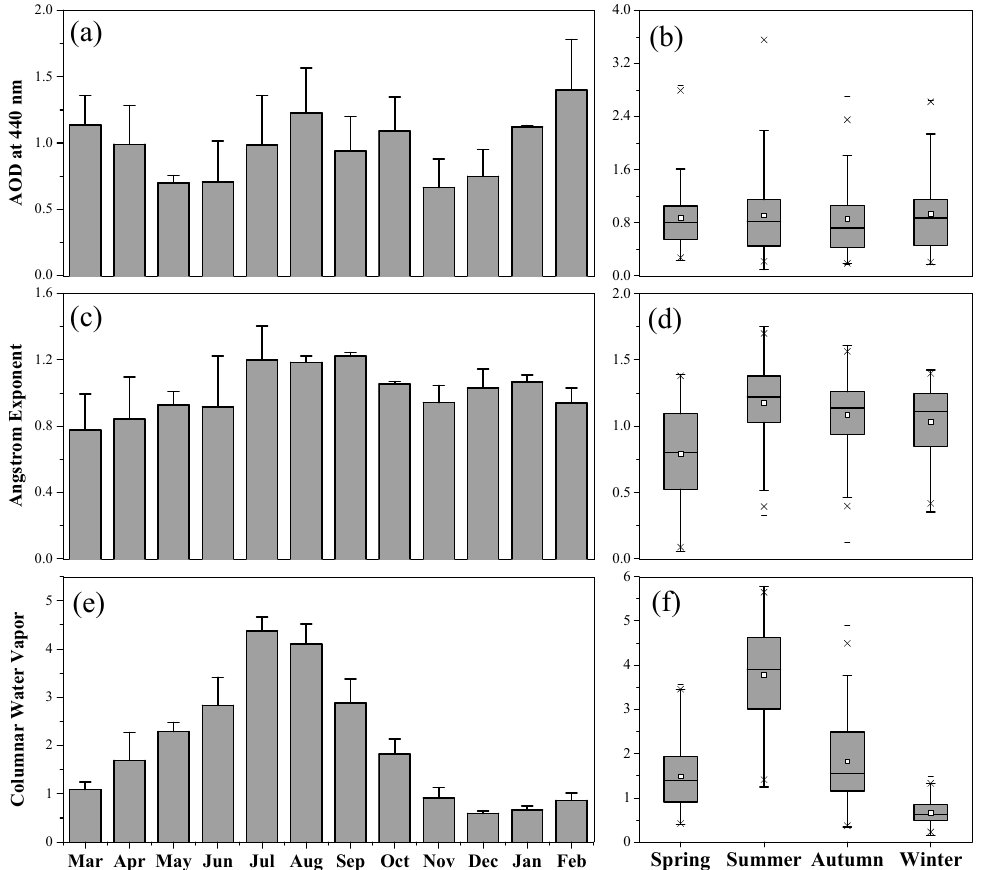
Figure 2. Monthly and seasonal average of AOD at 440 nm ( a , b ), Ångstrom Exponent (AE, 440–870 nm) ( c , d ) and columnar water vapor ( e , f ) at Xi’an site. In the box plots ( b , d , f ), the lines crossing the boxes denote the median, and the lower and upper limits are the first and third quartiles, respectively. The small squares in the boxes and the short lines at top and bottom indicate mean, maximum, and minimum values, while the crosses denote the 1–99% range. The whiskers denote 1.5 times of the difference between the first and the third quartiles. Compared with AOD, monthly and seasonal AE show different features. The monthly AEs did not vary as significantly as AOD did, but present an obvious seasonal variation. Monthly AE were normally larger than 1.0 in summer, autumn, and winter, with the highest value in September (1.24). The lowest AE occured in spring (~0.85), implying the significant impact of dust episodes on aerosol size distribution. Figure A2 shows the seasonal frequency distributions of AE at 440–870 nm in Xi’an. Similar to the AOD frequency distribution, the histograms of AE also presented a unimodal structure. The peak values distributed between 1.2 and 1.3 in most seasons except spring, when the monthly AE centered at 0.8–0.9. Daily AE fluctuated in the range of 0–1.8, suggesting that there were different sizes of aerosol particles in the atmosphere. For AE < 0.5, the relative frequency of AE was about 23% in spring, much higher than that in other seasons (<4%). High frequency of low AE values in spring indicates the influence of coarse dust particles. The frequencies of AE > 1.0 are about 33%, 79%, 72%, and 63% from spring to winter, respectively. Monthly and seasonal variations of CWV are also